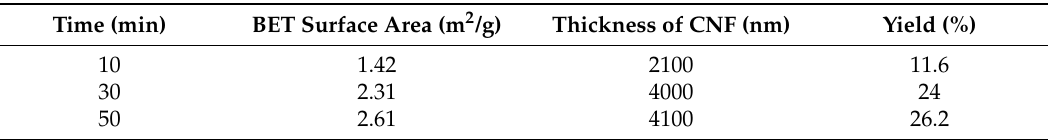
Table 3. Effect of growth time on CNF growth by use of 100 mM catalyst concentration at 550 ˝ C